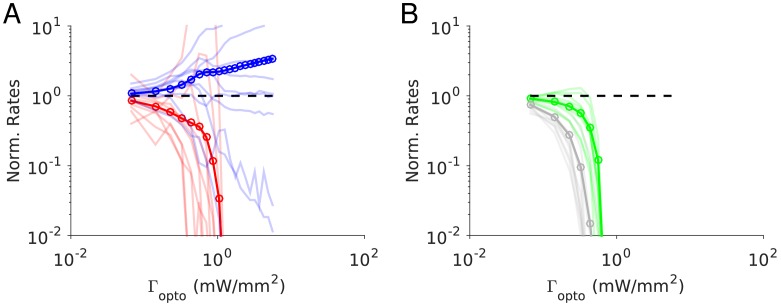
Numerical simulations of Model 1 for JEE>JEE*.Responses of the neurons normalized to baseline vs. the intensity of the laser, Γopto. (A) Activities of PCs and PV neurons: the PV response is not paradoxical. (B) Activities of SOM and VIP neurons. Color code as in Figure 4. Thick lines: population averaged responses. Thin lines: responses of 10 neurons randomly chosen in each population. Firing rates were estimated over 100s. Parameters: K = 500, N = 76800. Other parameters as in Tables 3–4. The baseline activities are: rE = 3.3 Hz, rI = 6.5 Hz, rS = 5.9 Hz, rV = 3.5 Hz.